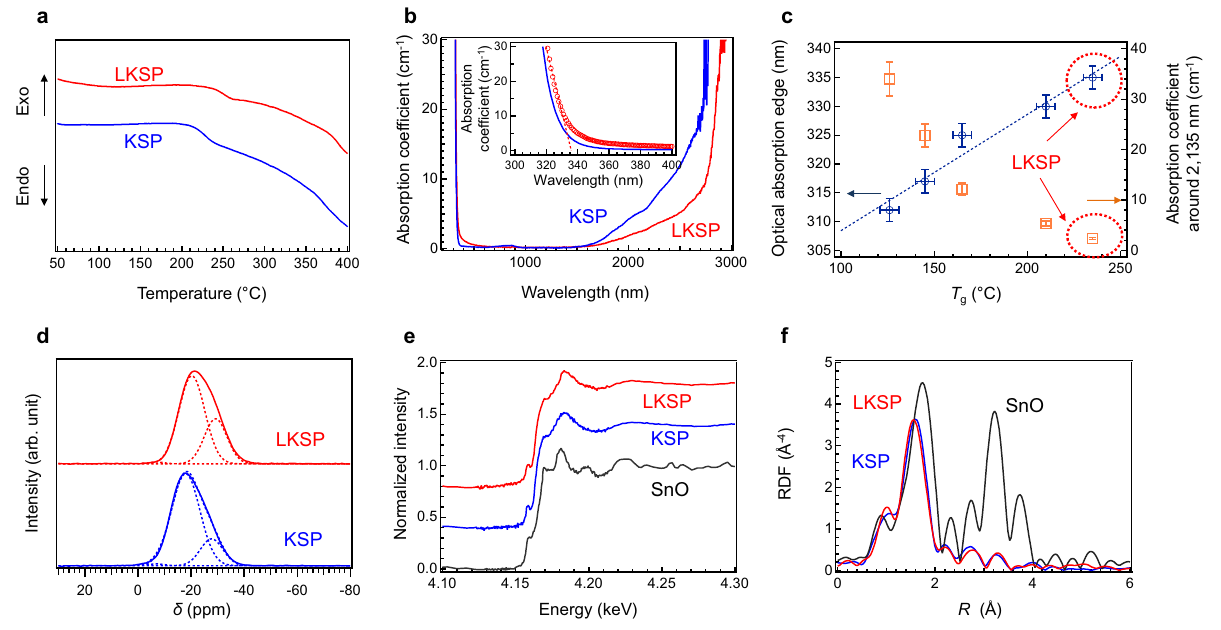
Figure 4. Effect of La 2 O 3 addition on KSP glasses. ( a) DTA curves of KSP glass and La 2 O 3 -doped KSP (LKSP) glass. ( b ) Optical absorption spectra of KSP and LKSP glasses. Inset shows the expanded absorption spectra at the absorption edge region. ( c ) Optical absorption edge and the absorption coefficient around 2,135 nm as a function of T g . ( d ) 31 P MAS NMR spectra of KSP and LKSP glasses. ( e ) Sn K-edge XANES spectra of KSP and LKSP glasses along with SnO. ( f ) FT of EXAFS of Sn K-edge XAFS spectra of KSP and LKSP glasses along with